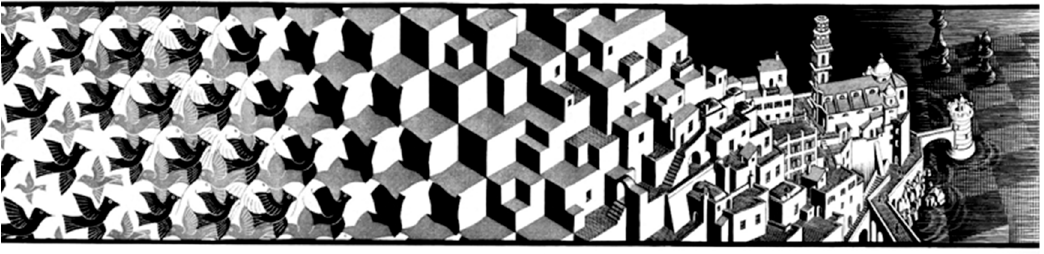
Figure 7. M. C. Escher, Metamorphosis II , 1940, detail.